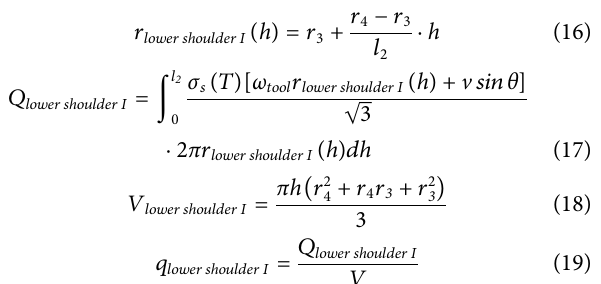
Frontiers in Materials |